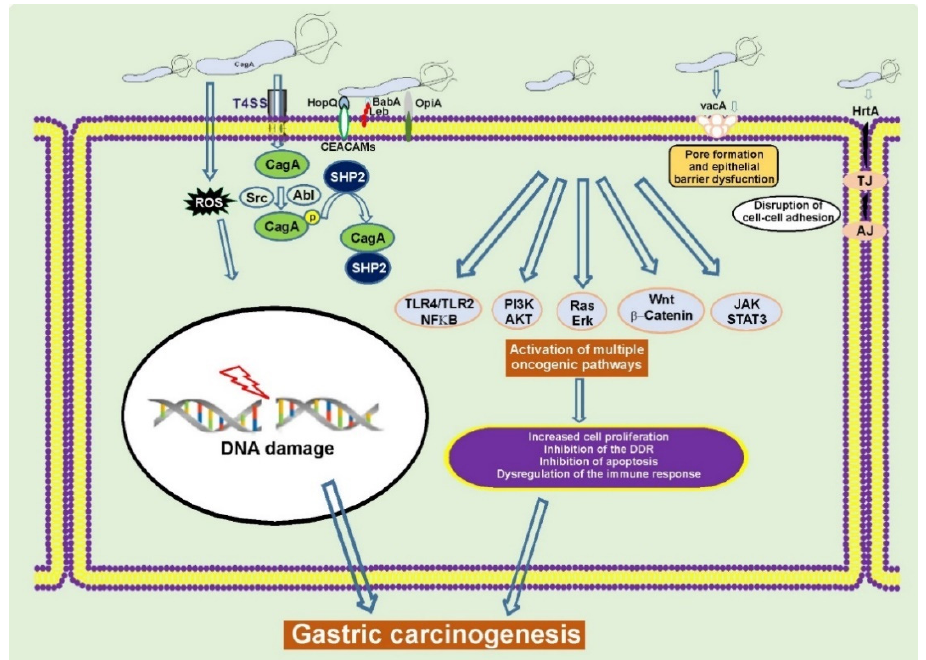
Figure 1. H. pylori alters cellular homeostasis during infection. H. pylori colonization of the human stomach is responsible for aberrant activation of multiple oncogenic pathways, induction of DNA damage, disruption of the epithelial barrier, and modulation of the host immune response. CagA, VacA, and other virulence factors play a key role in these processes [22,25,26].